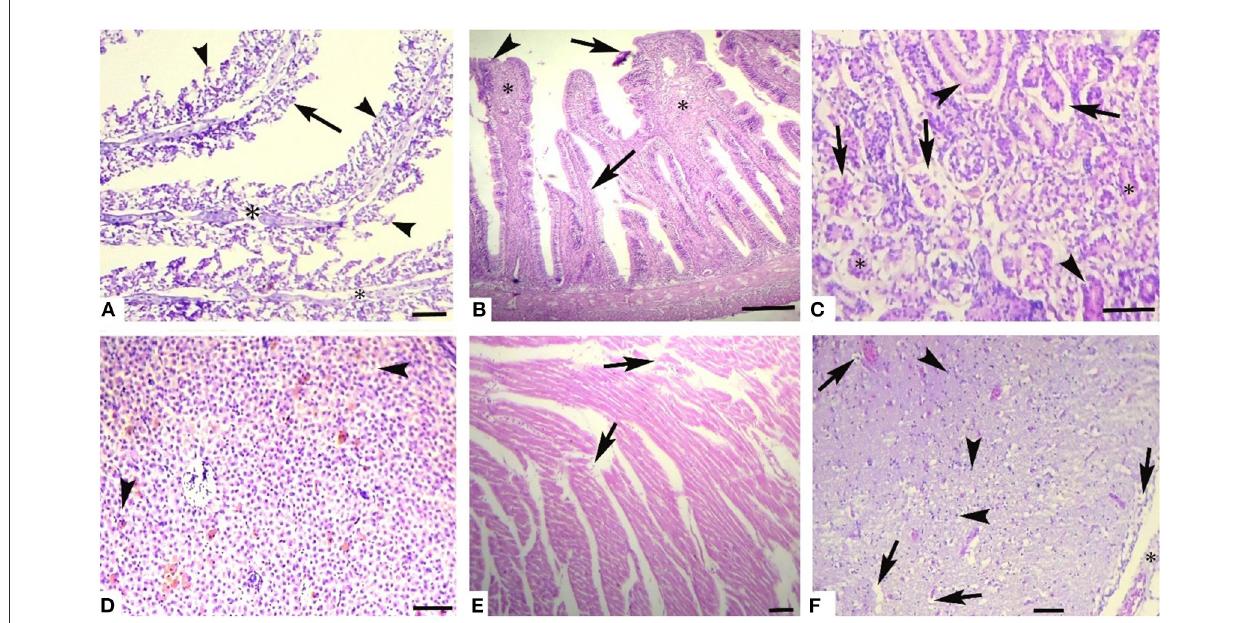
FIGURE1 Photomicrograph of different tissues of freshwater fish treated with CuSO 4 (0.42 µ g.L − 1 ) at experimental day 36: (A) Gills showing aneurysm (arrowheads), disorganization of primary lamellae (double asterisk) and necrosis of epithelium (arrows), (B) Intestine showing sloughing of epithelium from villi (arrows), necrosed epithelium (arrowheads) and necrosis of middle portio of villi (asterisk), (C) kidneys showing detachment of epithelium from the basement membrane (arrows), necrosis of renal tubules epithelial cells (arrowheads), protenecious material in tubulat lumen (asterisk) (D) Liver showing vacuolar degeneration (arrowheads) and necrosis of hepatocytes, (E) Heart showing disorganization of cardiac muscles (arrow), and (F) Brain showing necrosis of neurons (arrowheads), vacuolar degeneration of neurons (arrows) and microgliosis (asterisk). H and E. Bar is equal to (A) and (E) = 50 µ m, and (B–D) and (F) = 100 µ m.